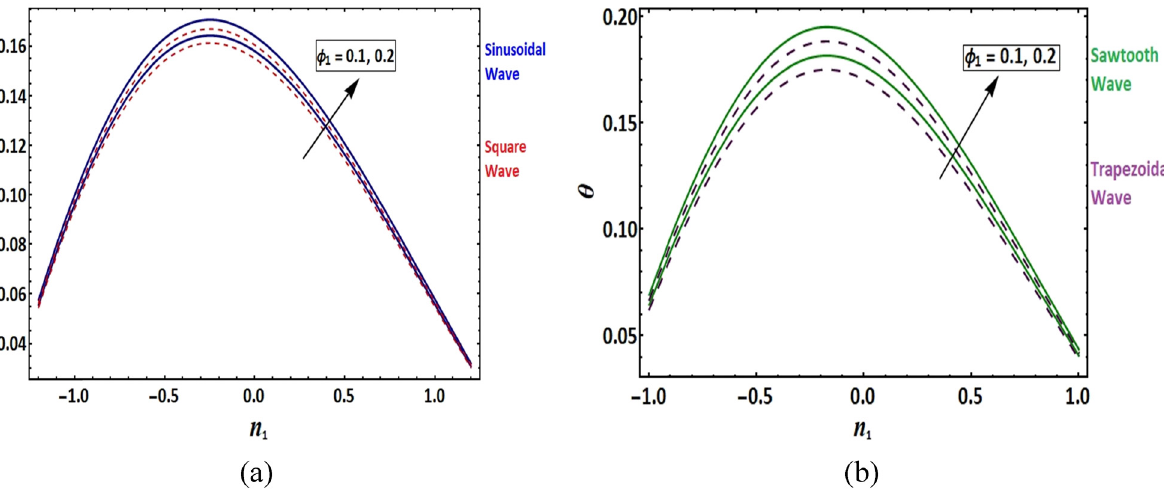
= 0.1, A = 2,Sr = 0.5, A = 1,Br = 0.5, K = 2, K = 3, ϵ 0.2 = , B 4 1 3 3 1